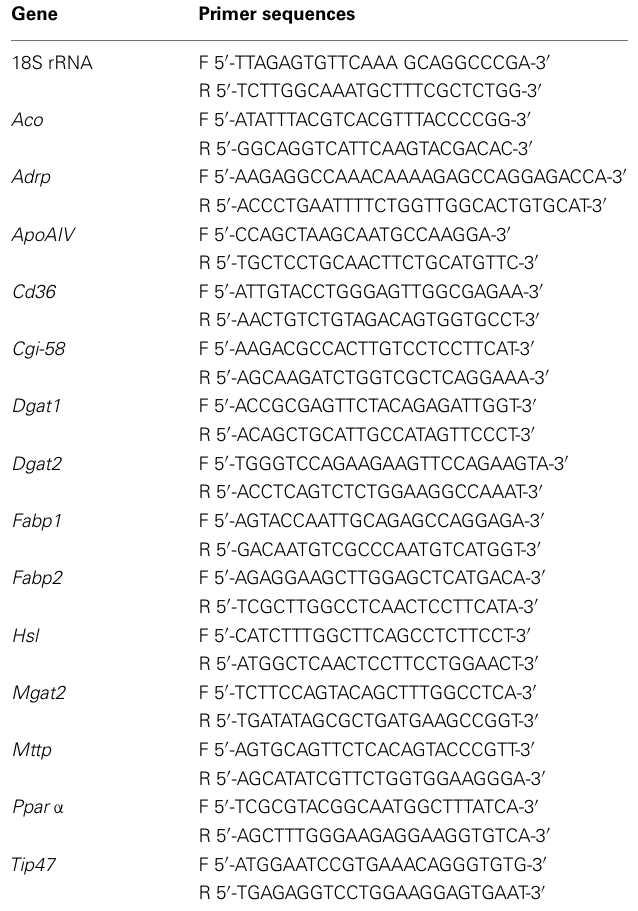
Table 1 | Primers used for quantitative real time